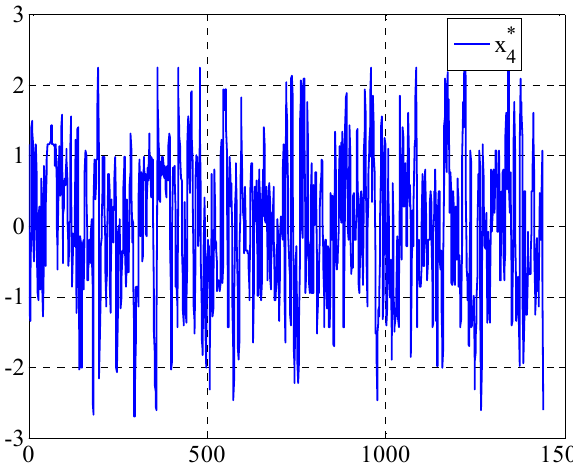
of carbon content of fly ash (2# boiler). 4